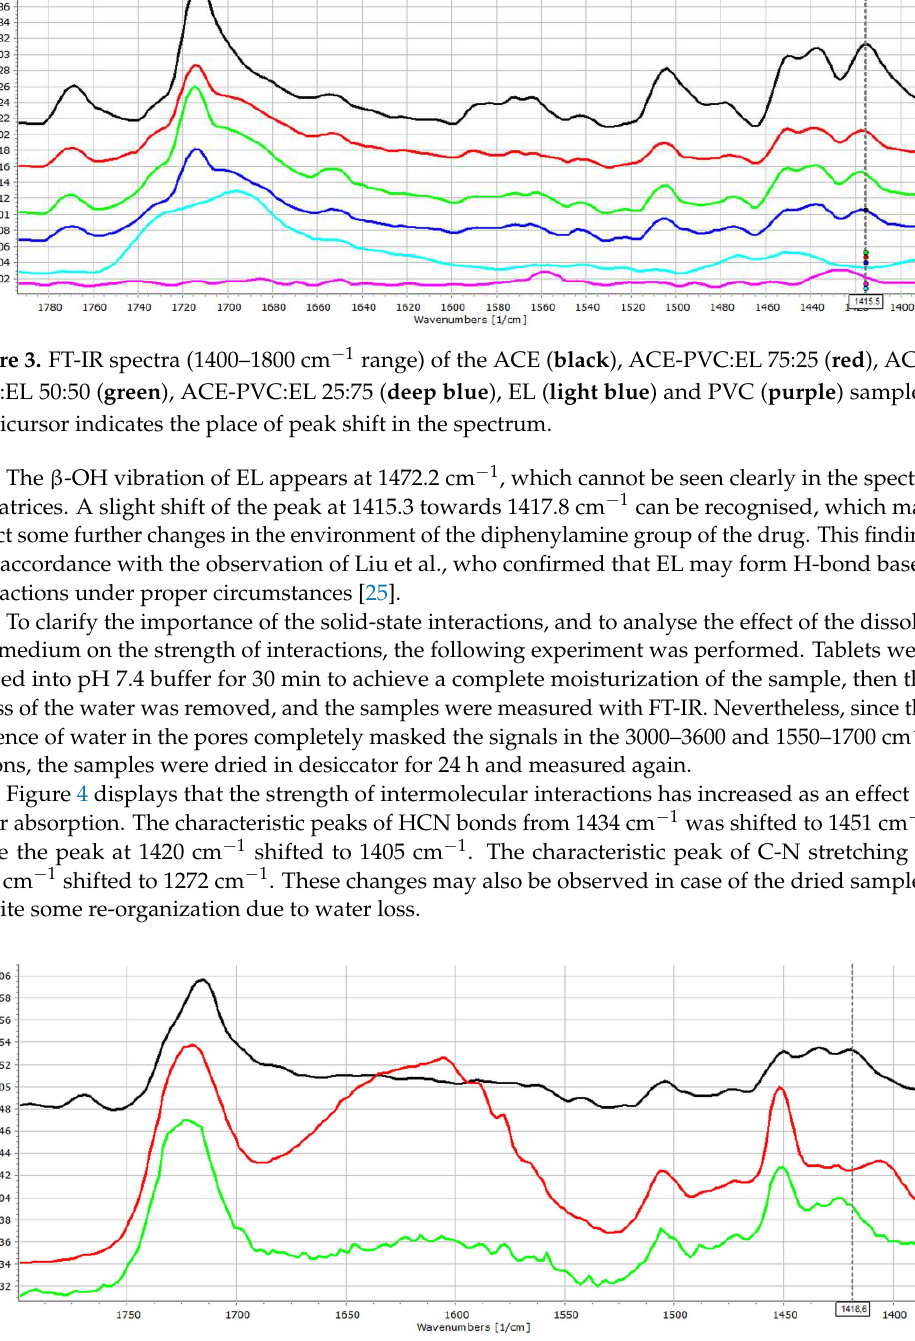
Figure 5. FT-IR spectra of ACE-PVC:EL 75:25 samples: original ( black ), dipped ( red ), and dried ( green ). As expected, the matrices prepared with DIS exhibited fewer spectral changes after compression, primarily due the weaker acidity of the drug, but the higher porosity may also play a possible role in this phenomenon. Similarly, as in the ACE-containing compo- sitions, the most obvious changes may be found in the C=O stretching region. The charac- teristic peak doublet may be found at 1555 and 1571 cm −1 , where the shift of the peak intensities in the direction of 1571 cm −1 may be observed with increasing Eudragit content. As expected, the shift is less intensive in the case of EL-containing compositions (Figure S1) than in EE-containing ones (Figure S2). Some further signs of mild interactions and